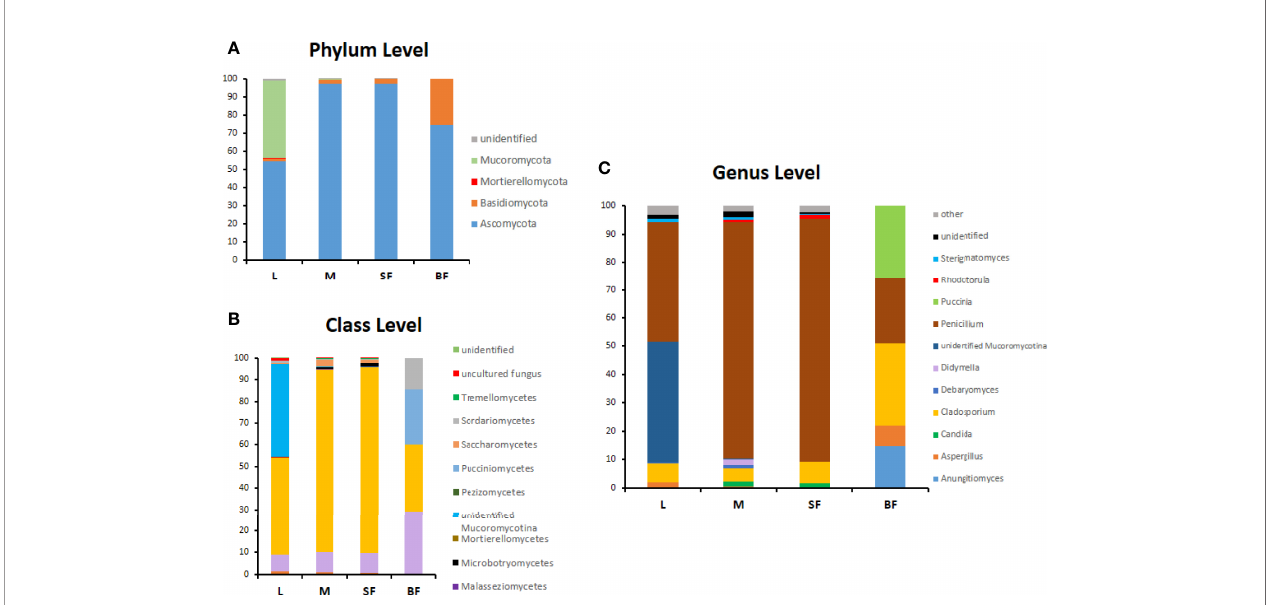
FIGURE 4 | Relative abundance (%) of fungi along Cx. quinquefasciatus development at the phylum (A) , class (B) and genus level (C) . OTUs with values >1% were grouped under other genera in panel (C)